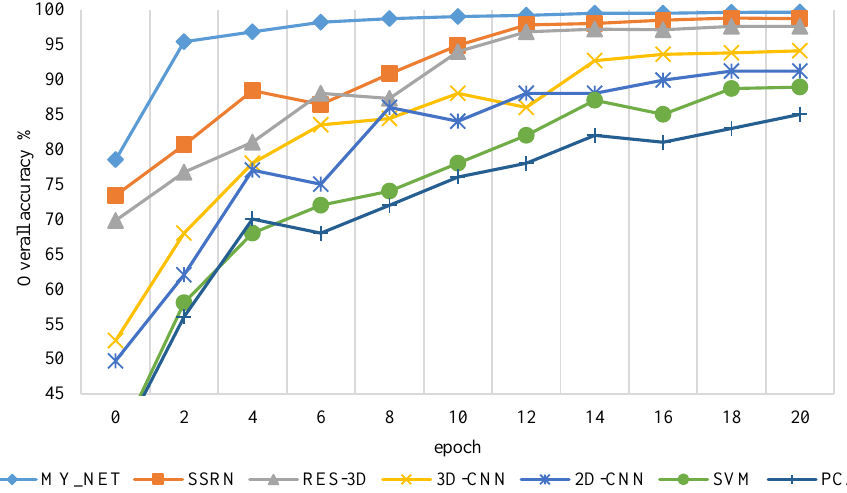
Figure 14. Overall accuracy curve of different models in KSC dataset. Table 5. Classification results of different models in KSC.